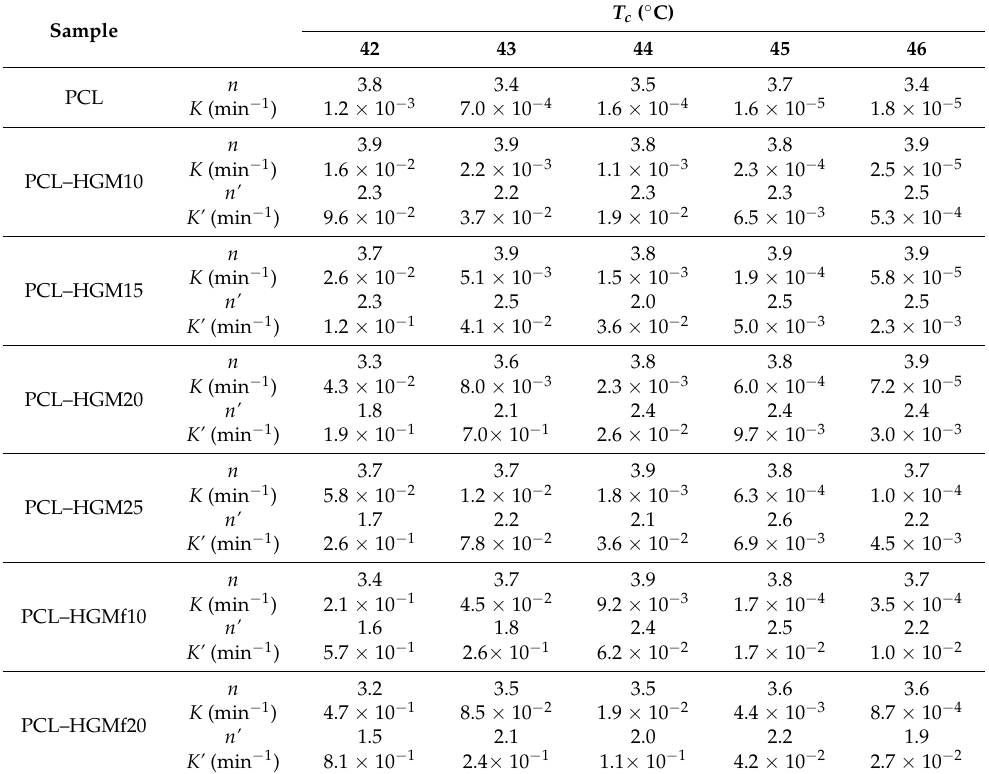
Figure 4. Plots of log[ − ln(1 − X r )] vs. log t for isothermal crystallization of PCL ( a ), PCL-HGM10 ( b ), and PCL-HGMf10 ( c ) at different T c . and PCL-HGMf10 ( c ) at different T c . Table 2. Half-time of crystallization and Avrami parameters of PCL and